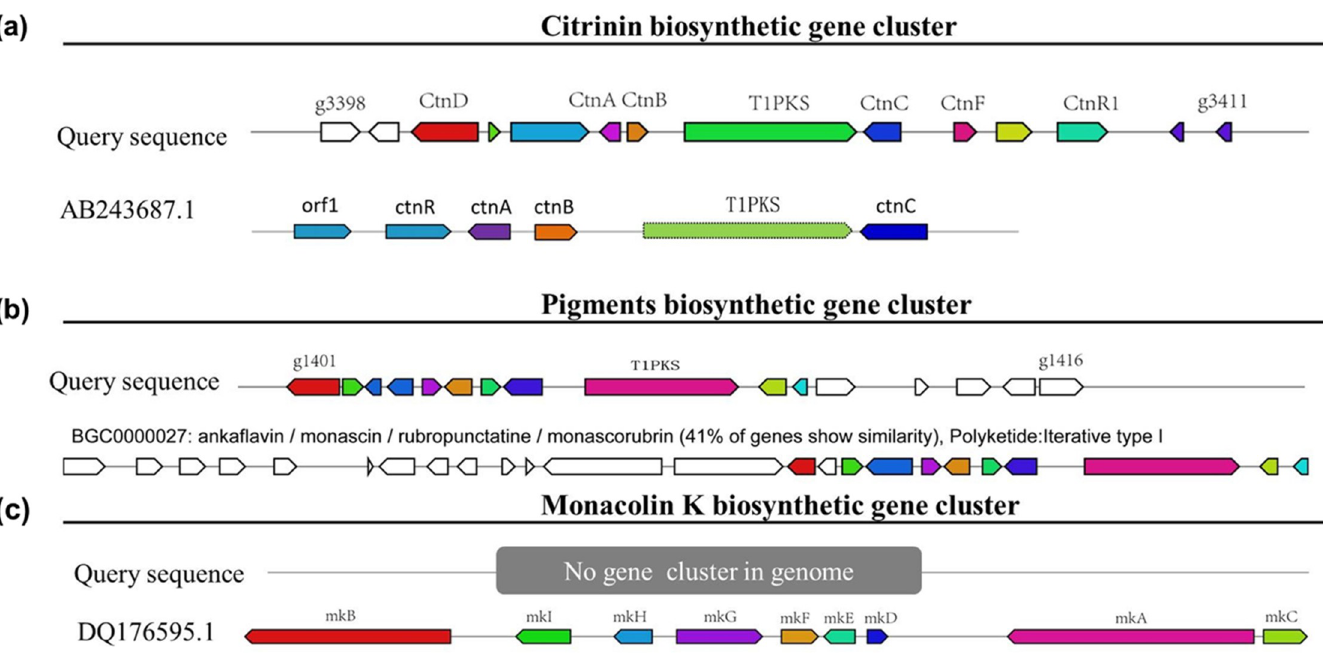
Fig 2. Schematic representation of predominant secondary metabolites BGCs in the genome sequence of M . purpureus CSU-M183. (a) Citrinin. (b) MPs. (c) Monacolin K.